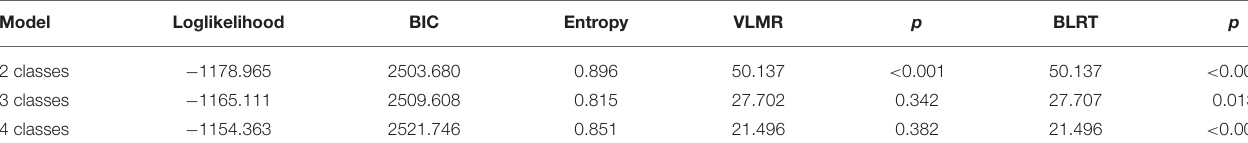
TABLE 2 | Model comparisons and latent profile analysis of the Five Cs.